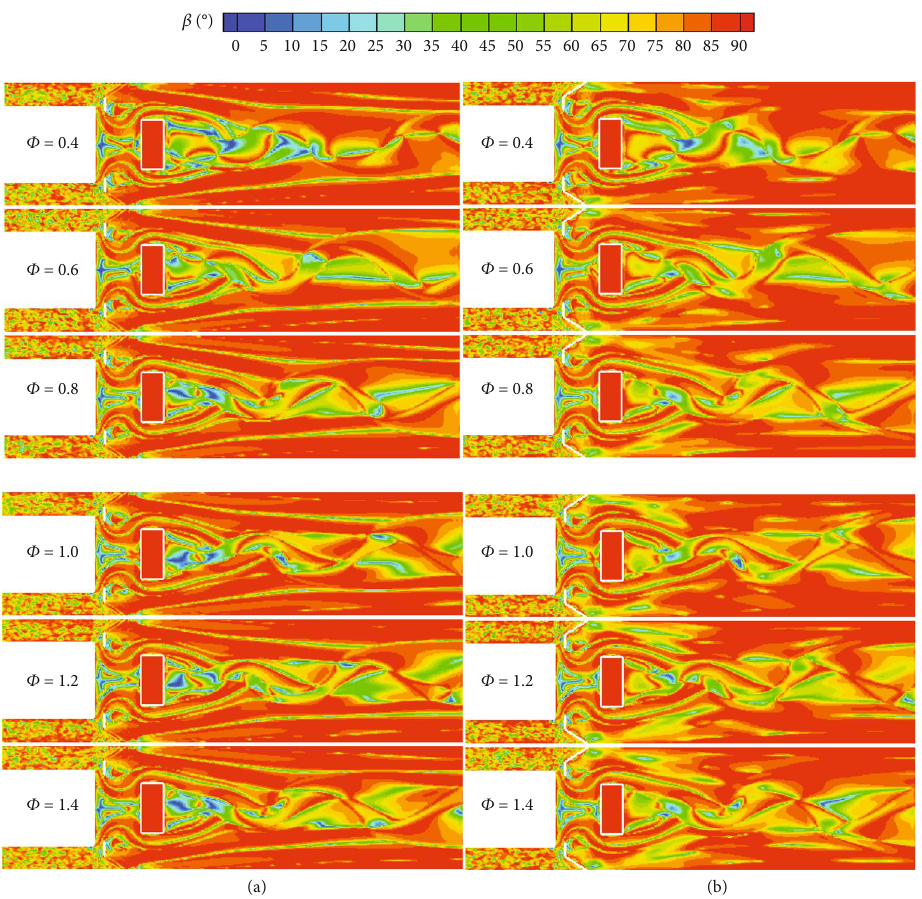
Figure 21: Average synergy angle distribution under di ff erent equivalent ratio.